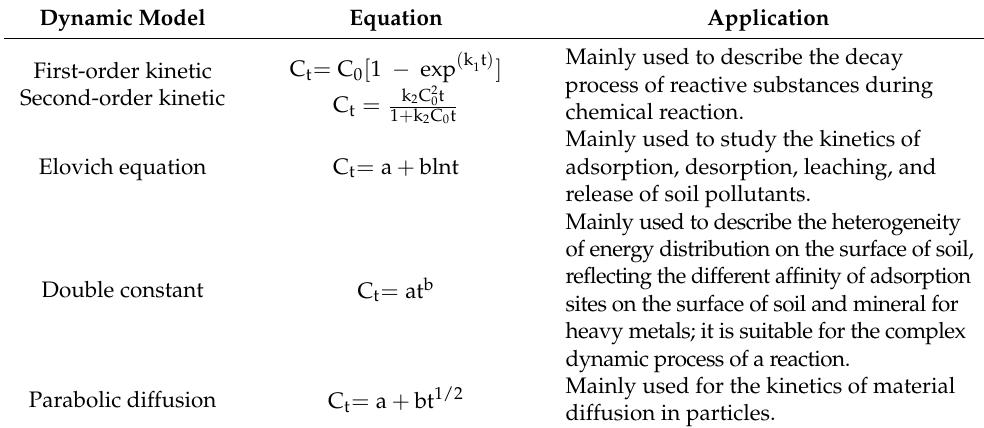
Table 2. Basic parameters of different dynamic models.